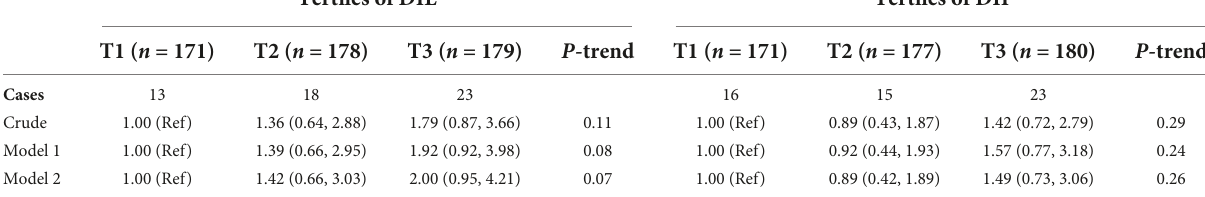
TABLE 5 Multivariate adjusted odds ratio (OR) and 95% confidence interval (CI) for very low BDNF ( < 0.47 ng/mL, 1st decile) across tertiles of DIL and DII a . Tertiles of DIL Tertiles of